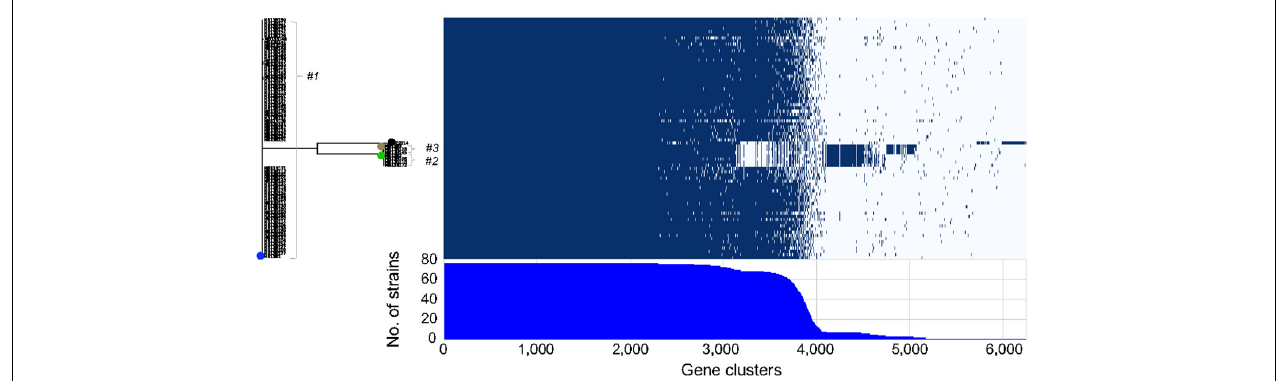
FIGURE 5 | Roary matrix indicating the presence or absence of genes in 6246 clusters among 75 light-organ isolates from lobe MB13B within clusters #1-3 . Strain ES114, isolated from another light organ, is included for comparison (black dot). The positions of previously sequenced strains are indicated by blue (MB13B1), green (MB13B2), and brown (MB13B3)